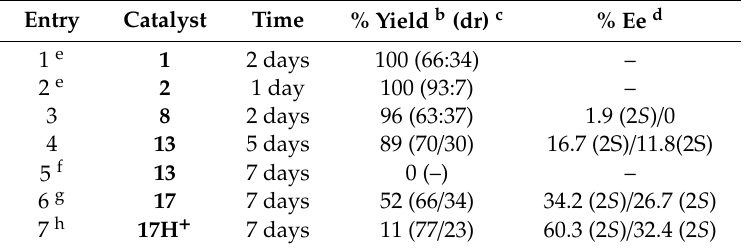
Table 1. Catalysis of the aqueous aldol reaction of cyclohexanone with 4-nitrobenzaldehyde a